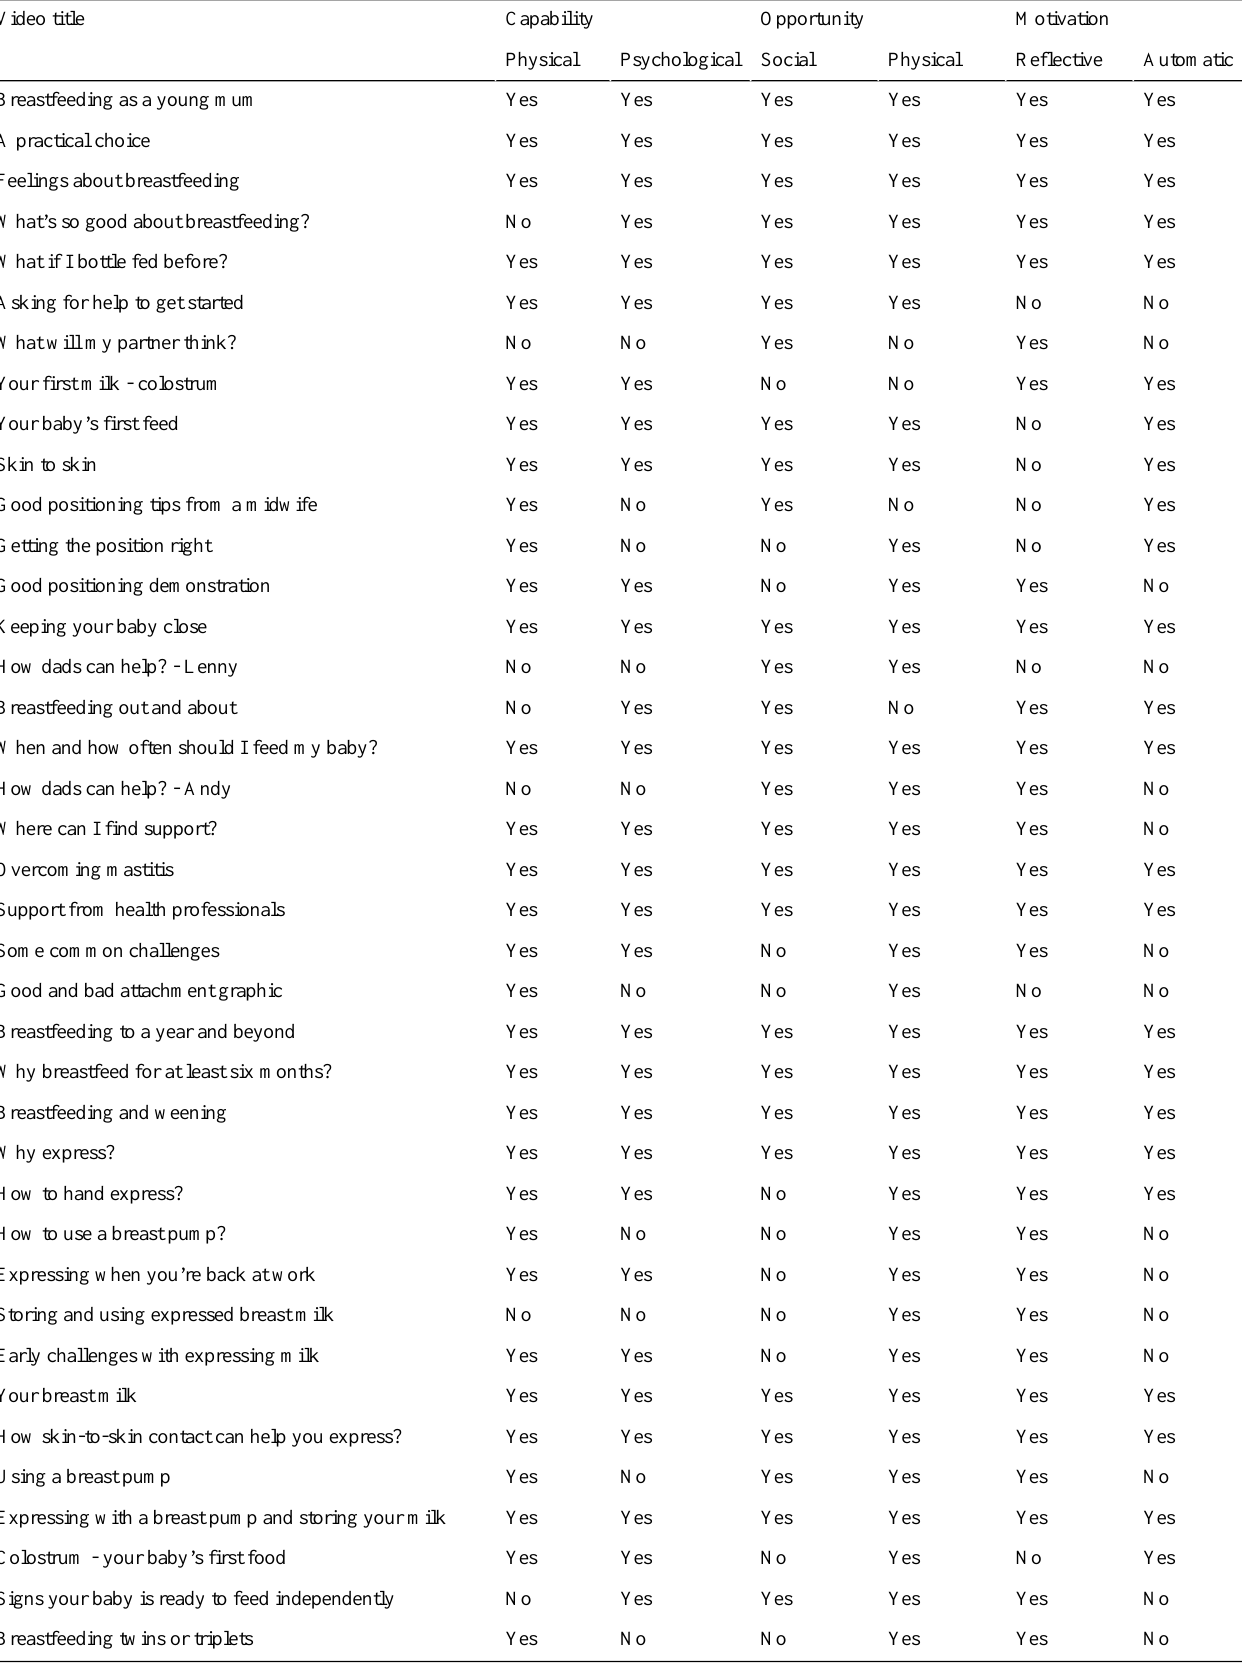
Table 2. Mapping of breastfeeding video content to the Capability, Opportunity, and Motivation-Behavior (COM-B) tool. MotivationOpportunityCapabilityVideo